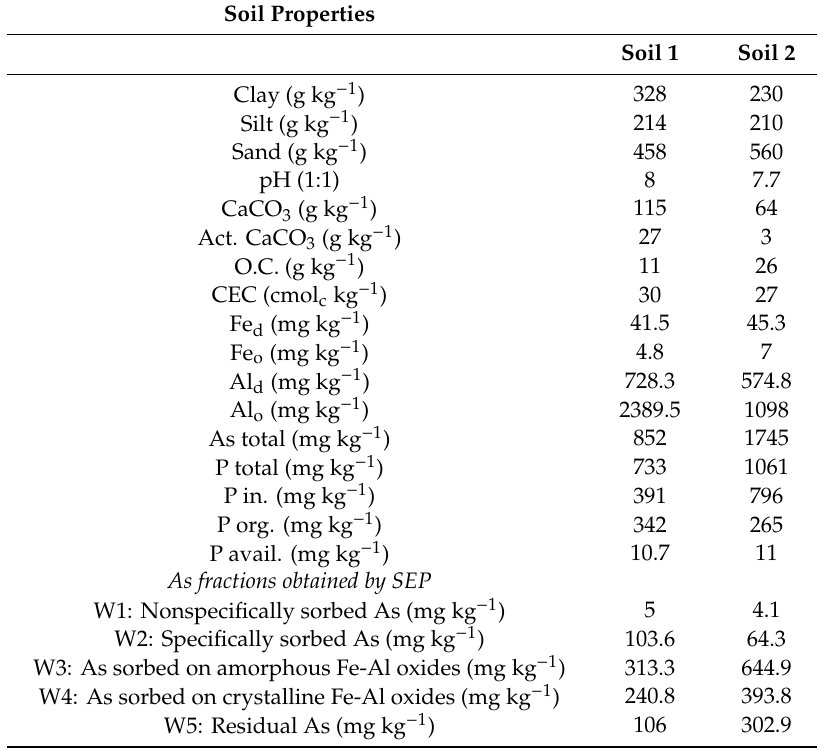
Table 1. Main physicochemical soil properties and the results of As fractionation following Wenzel et al. (2001) [30] sequential extraction protocol